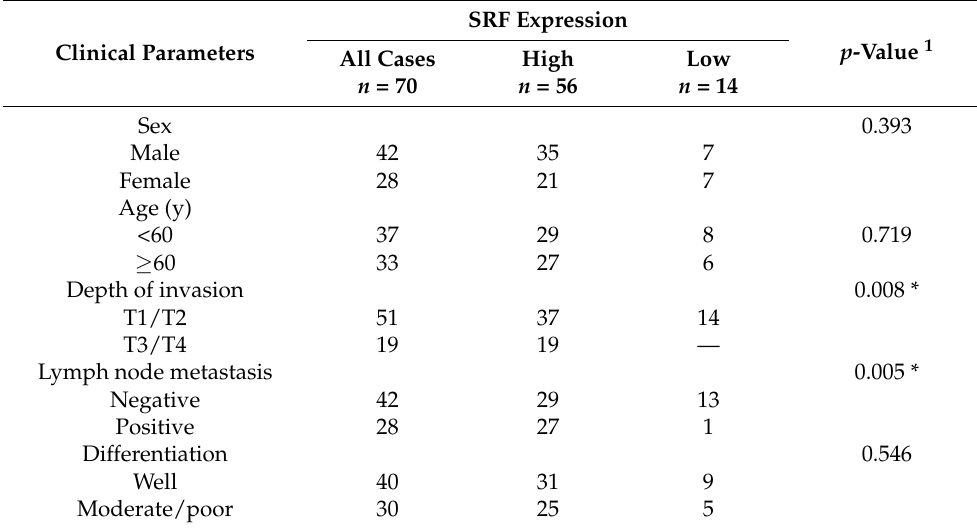
Table 1. Relationship between SRF expression and clinicopathological characteristics of patients with oral squamous cell